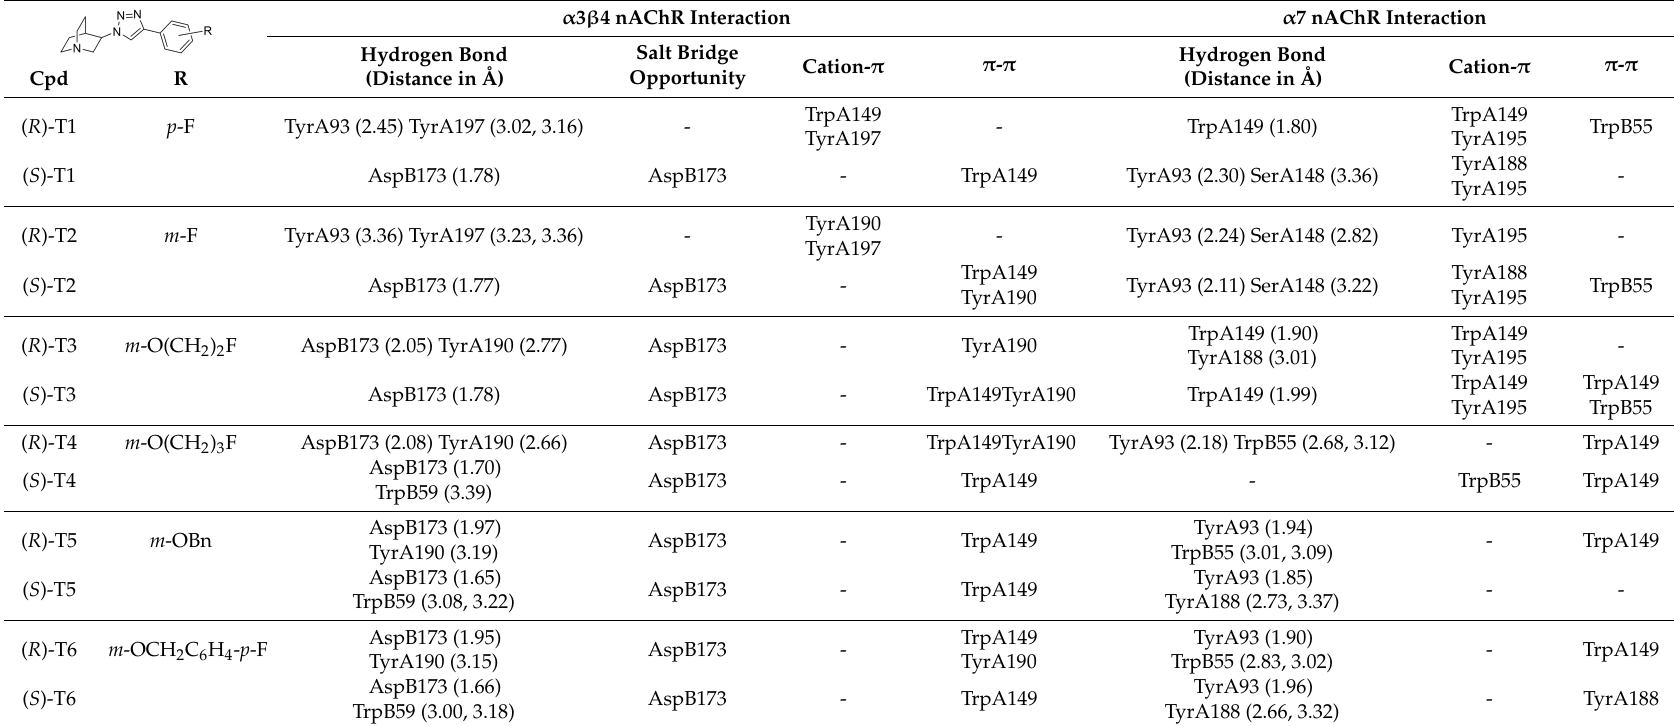
Table 3. The amino acid residues involved in the binding interaction to α 3 β 4 and α 7 nAChRs.